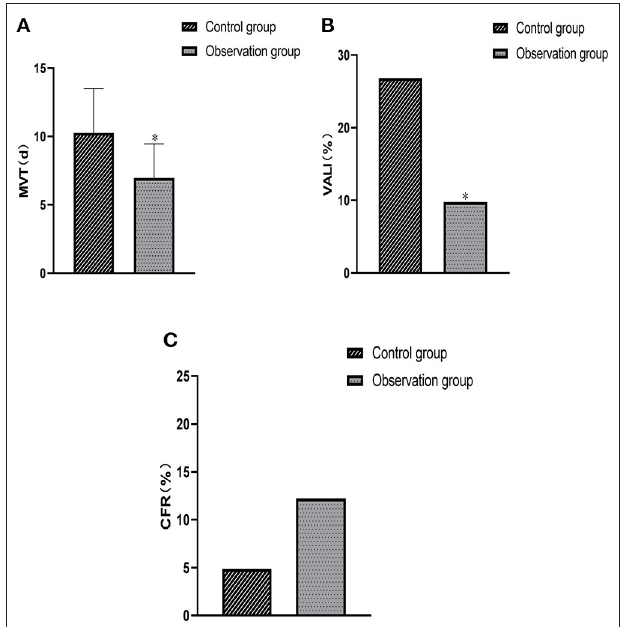
FIGURE 1 | Comparison of clinical efficacy between the two groups. (A) Comparison of average MVT. (B) Comparison of the occurrence of VALI. (C) Comparison of CFR. Compared with the control group, * P < 0.05.